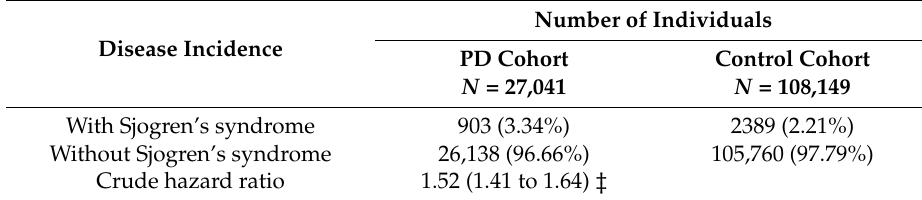
Table 2. Association between PD and Sjögren’s syndrome (SS) analyzed by employing a Cox regression